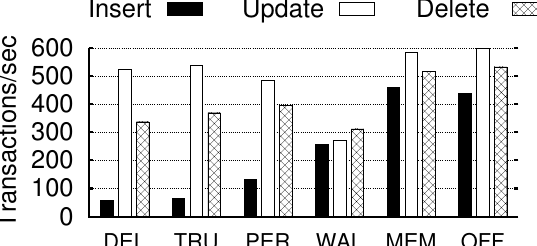
Figure 11. SQLite operation with various journal modes on internal eMMC. Sync mode: FULL; SQLite version: 3.7.5 [Samsung Galaxy S4, Android 4.2.2 (JB), /data